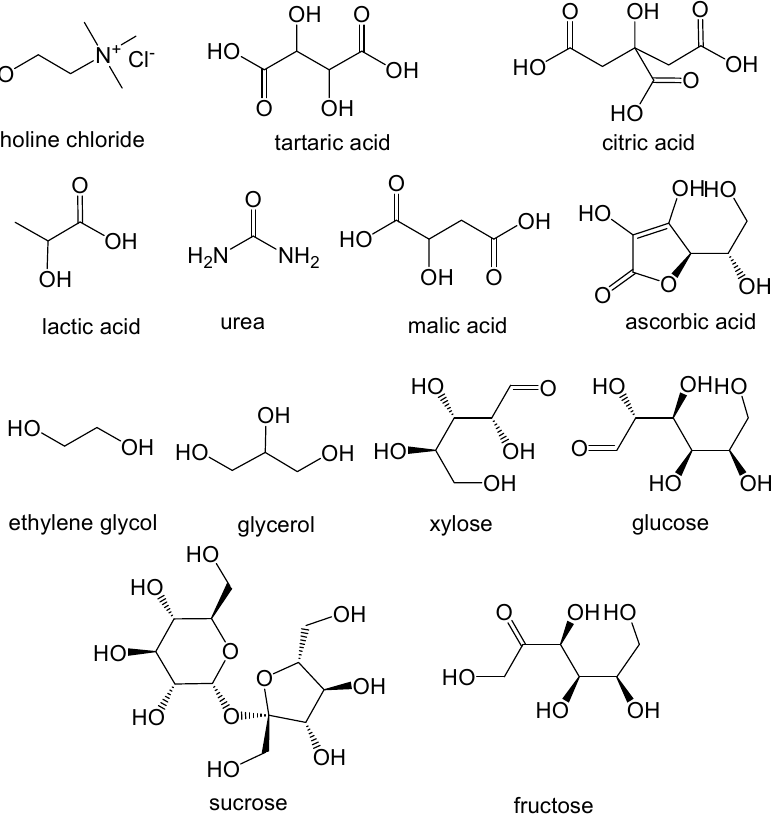
Figure 1. Chemical structure of some compounds that can be constituents of Natural Deep Eutectic Solvents.